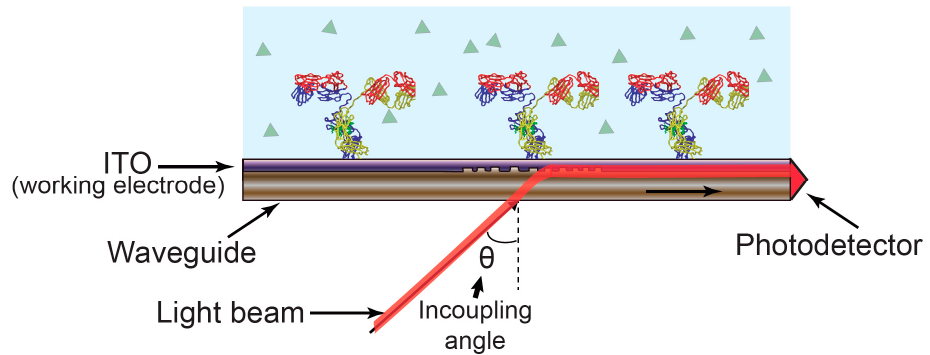
Figure 5. Electrochemical optical waveguide lightmode spectroscopy (EC-OWLS). The angle of light coupled into the waveguide by the grating depends on the refractive index of the molecules attached to the sensor surface while the indium tin oxide (ITO) provides an electrically conductive layer to support electrochemistry.